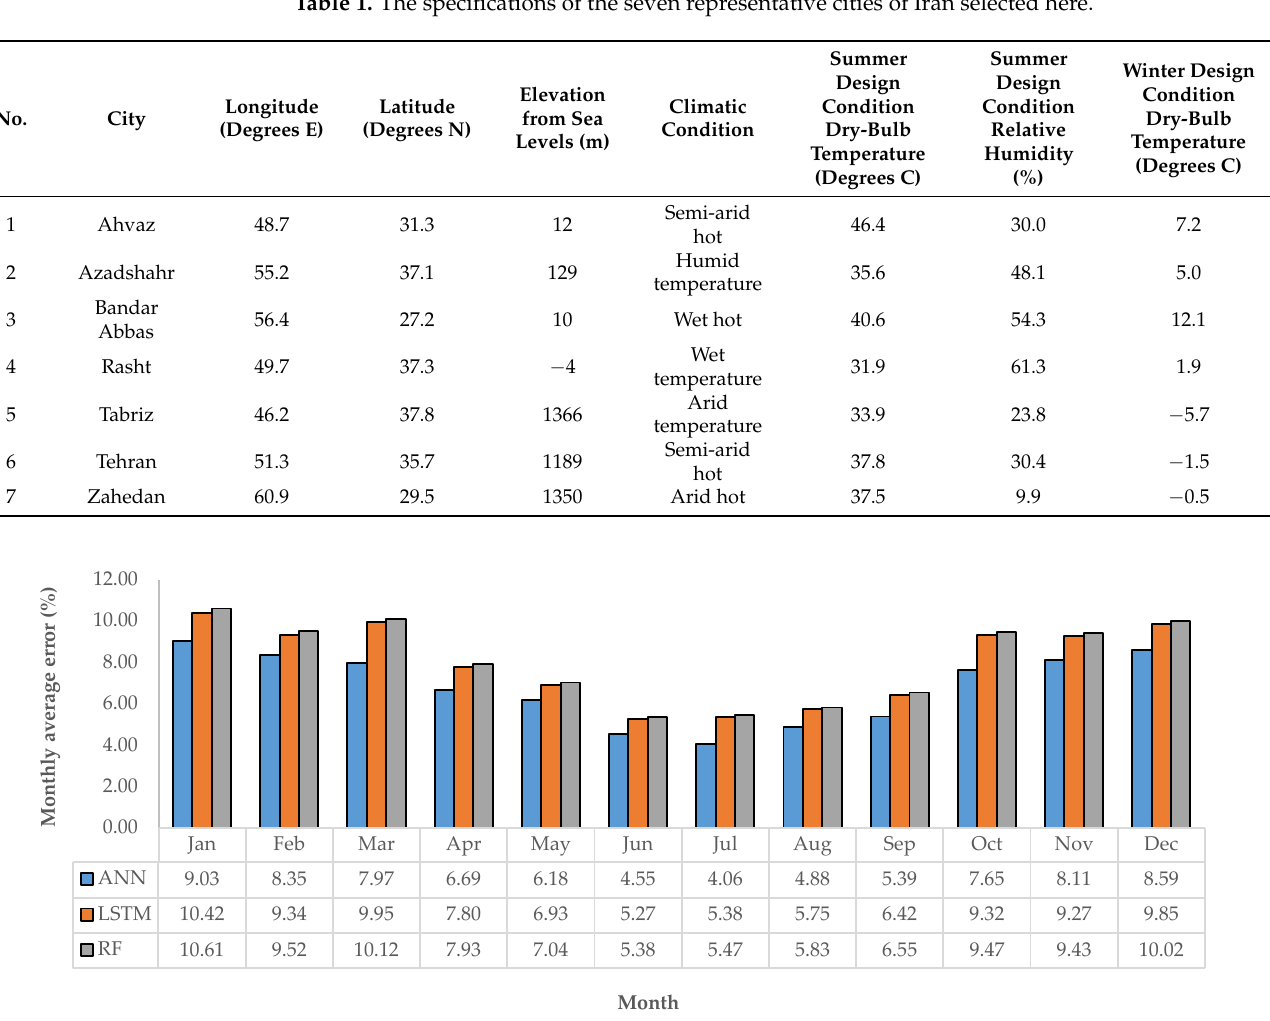
Figure 2. The annual estimation error profile of yield by ANN, LSTM, and RF models for city Tehran using the experimental data of [16].